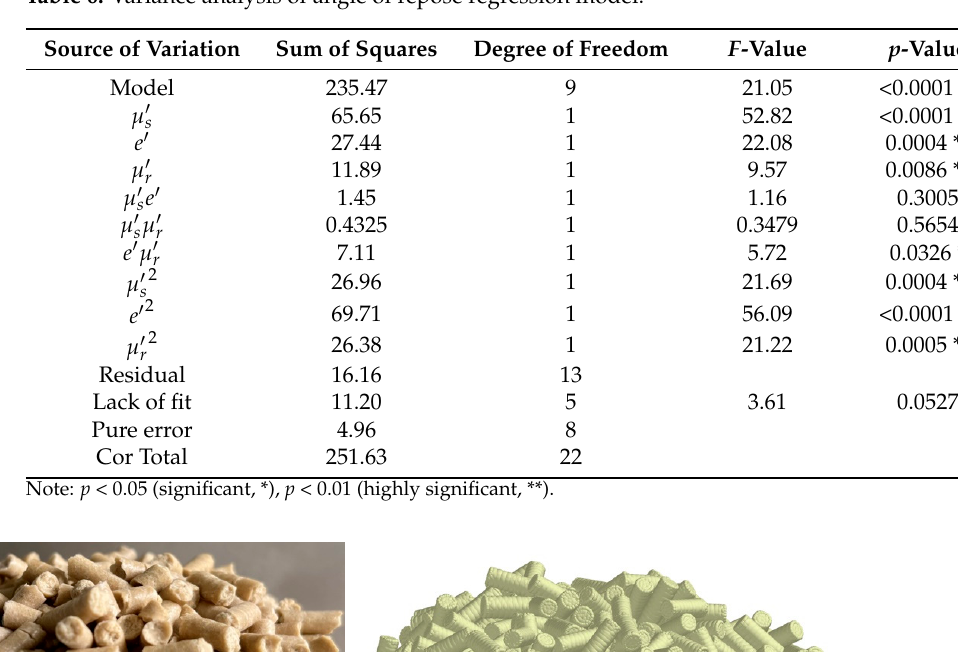
Table 6. Variance analysis of angle of repose regression model.